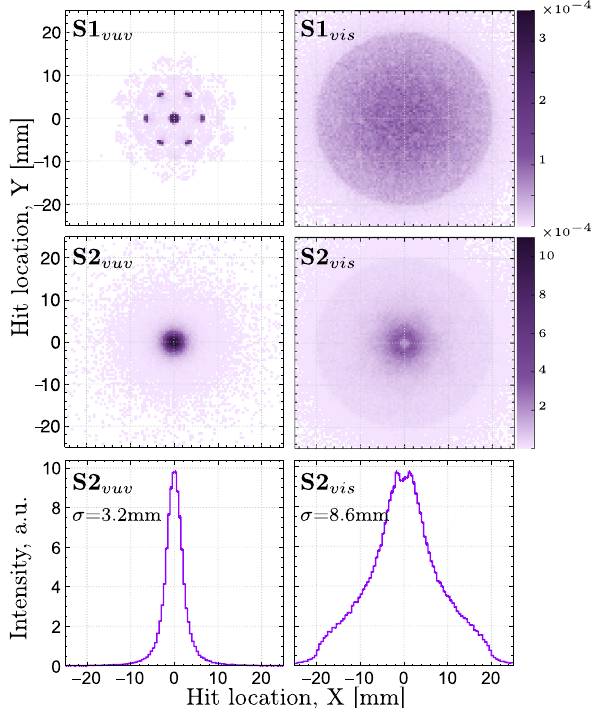
Fig. 3 Photonhitlocationsataphotodetectionplaneplaced3mmafter the WLS FAT-GEM. Shown separately: x – y maps for VUV (left col- umn) and visible (right column) photons from S1 (top) and S2 (middle), and x -axis projections of S2 hits (bottom). The standard deviation, σ , is given for S2 projections. The histograms are divided by the initial 10 6 of generated VUV photons and have 0.5 mm-wide bins. Clusters of VUV hits from photons transmitted directly through GEM holes are visible on top of a broader distribution caused by diffuse reflections